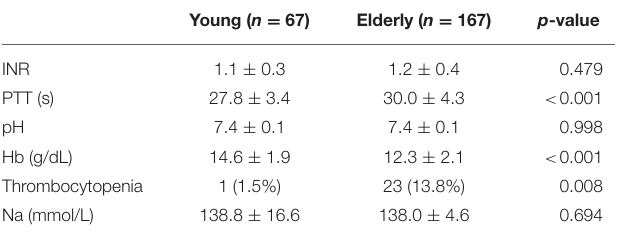
TABLE 4 | Laboratory results.